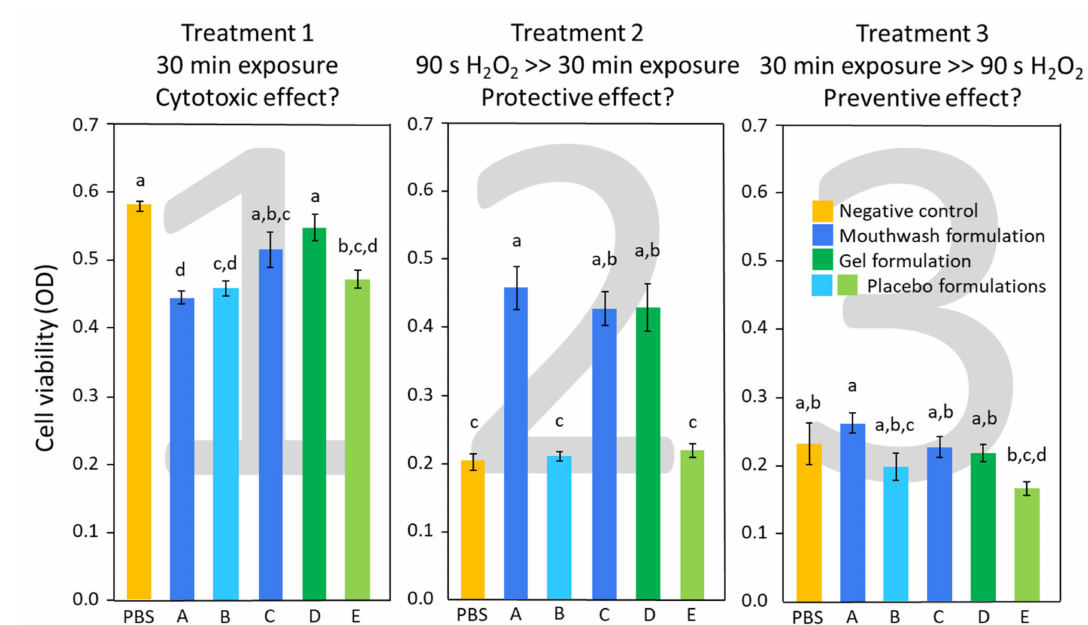
Figure 3. Viable and metabolically active RHOE cells. Results are displayed in optical density units as means ± 1 standard error (whiskers). Different superscript letters indicate statistically significant differences between groups (Tukey’s test, p <